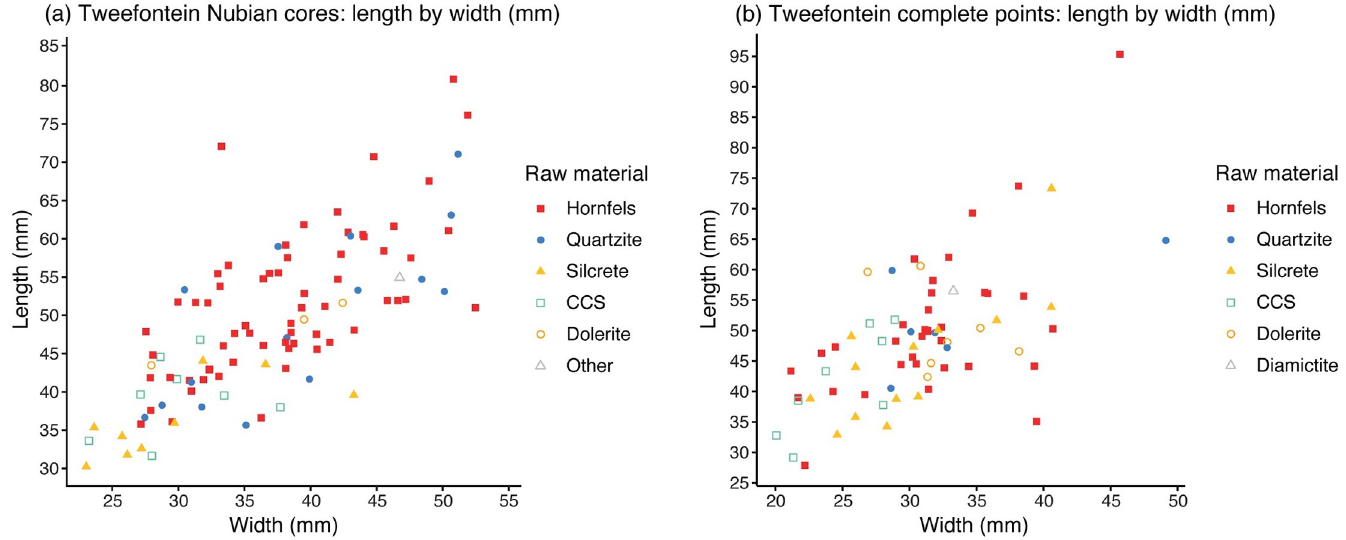
Fig 11. Scatter plots showing artefact length by width. (a) Nubian cores and (b) points.